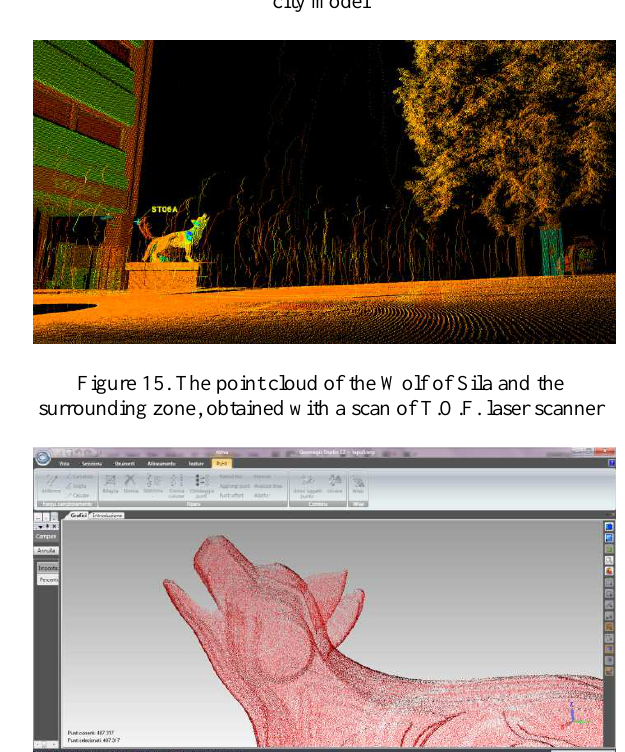
Figure 18. The deviations points-model (from the VIVID 300 scans) for the head of the Wolf of Sila